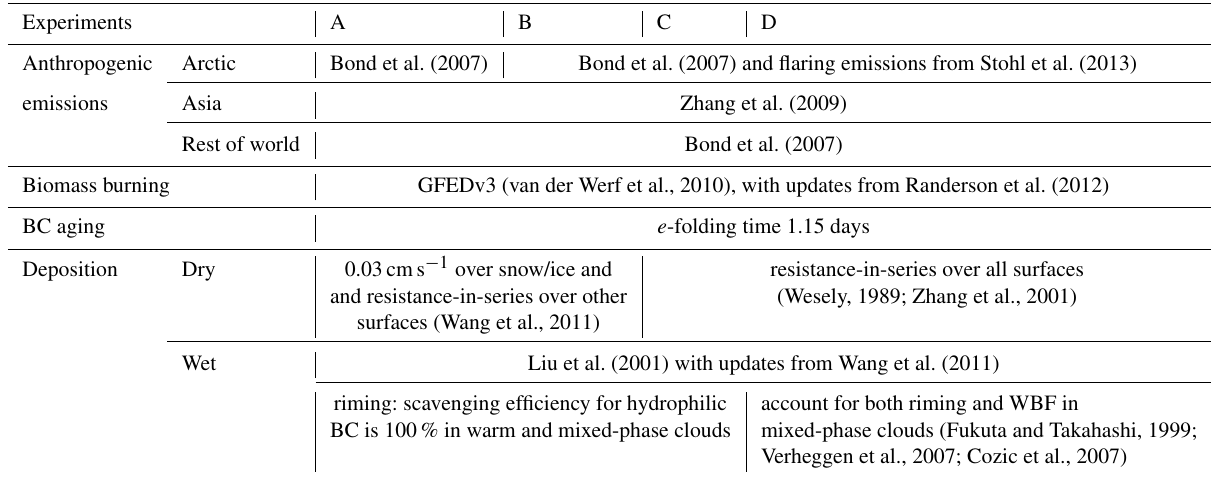
Table 2. GEOS-Chem simulations of BC in the Arctic.